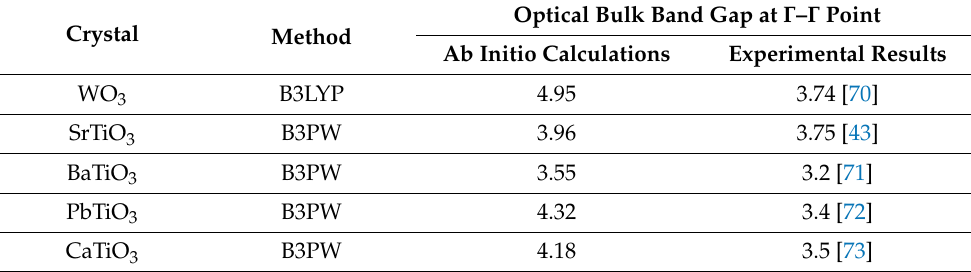
Table 4. Ab initio-calculated WO 3 , SrTiO 3 , BaTiO 3 , PbTiO 3 and CaTiO 3 bulk band gaps for the cubic phase at the Γ – Γ point. Our B3LYP and B3PW calculations were compared with the relevant experimental